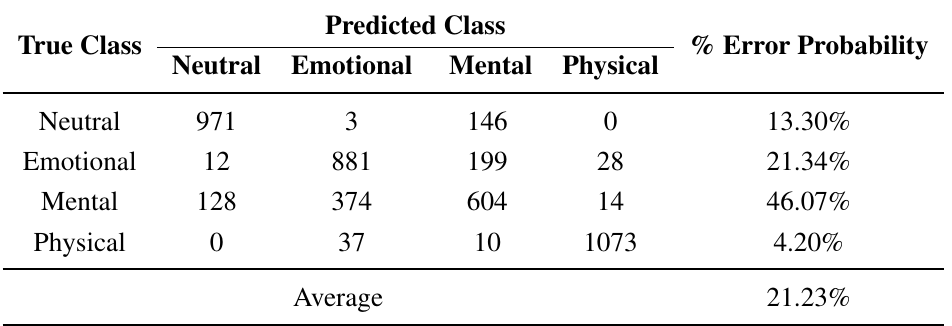
Table 3. Confusion matrix and percentage of classification error (error probability) for each class using a maximum number of 80,000 operations per second ( N particularized for Analysis 1: type of activity.